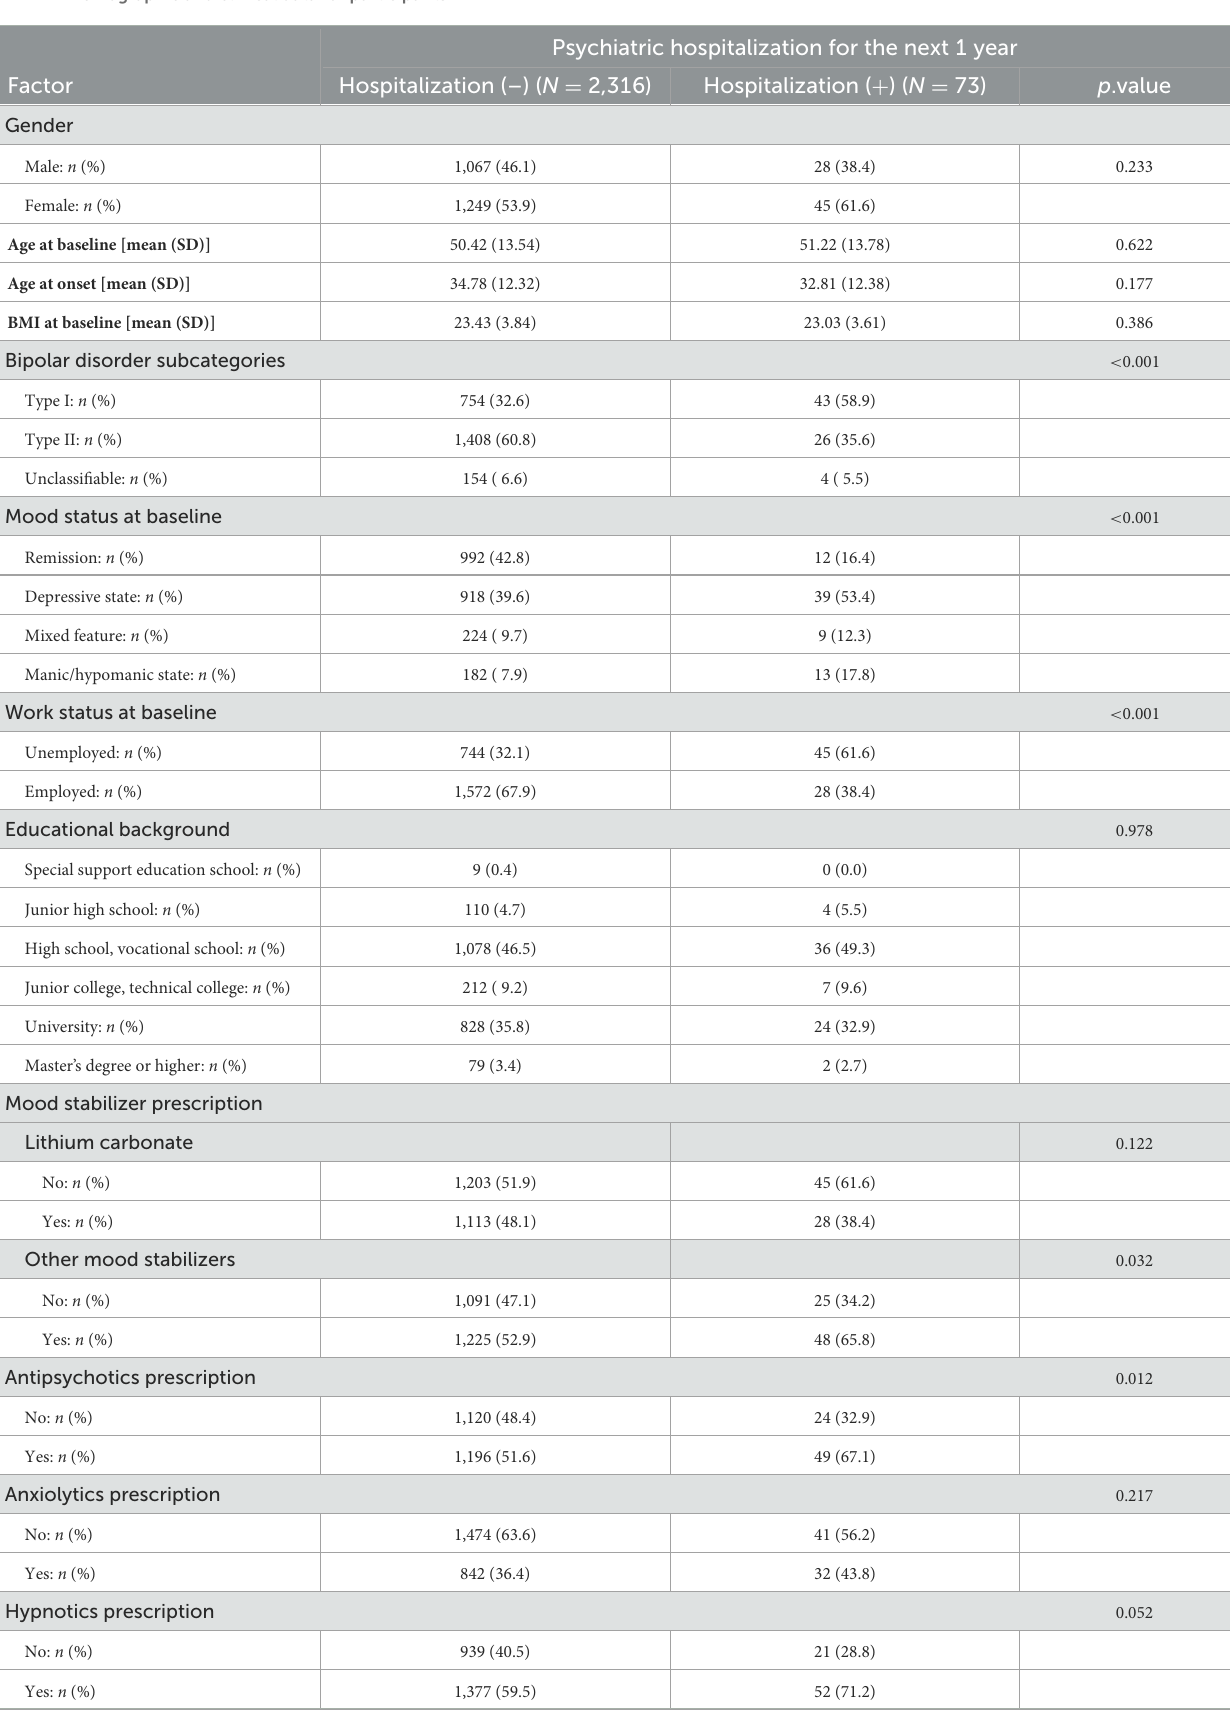
TABLE 1 Demographic and clinical data for participants.